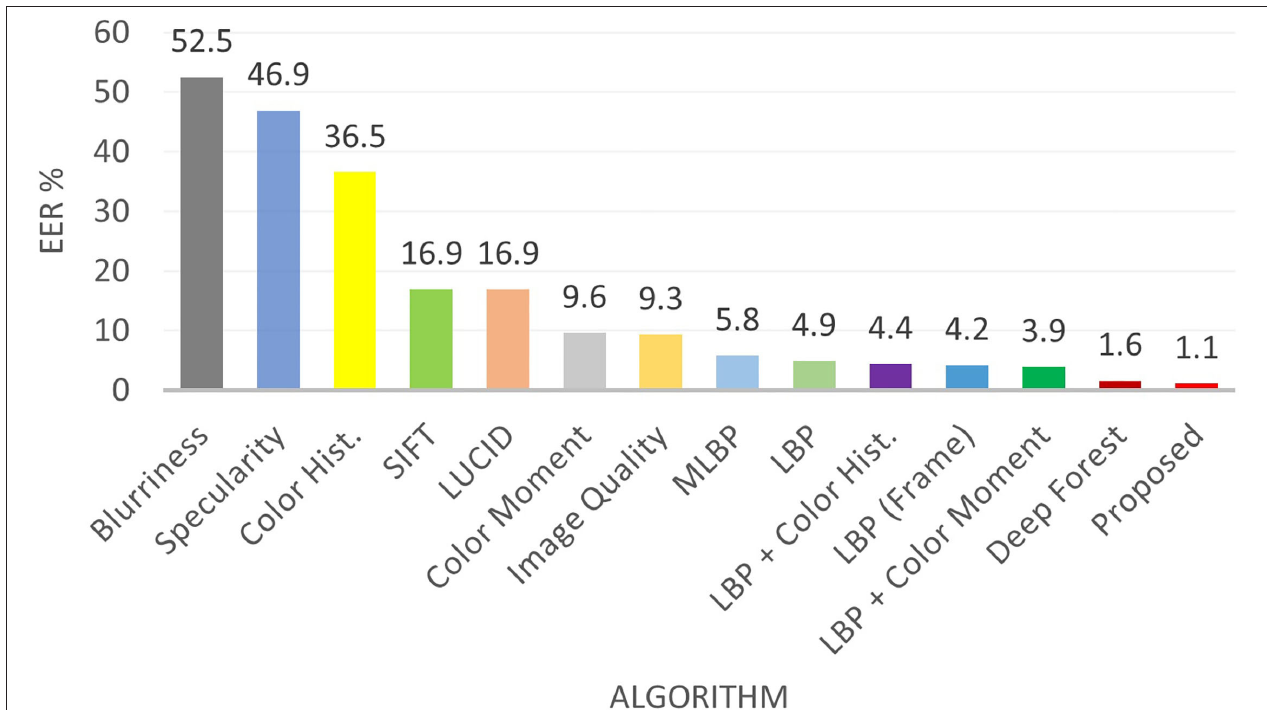
FIGURE 4 | Comparison with existing results including deep forest (Cai and Chen, 2019) on the MSU USSA database for presentation attack